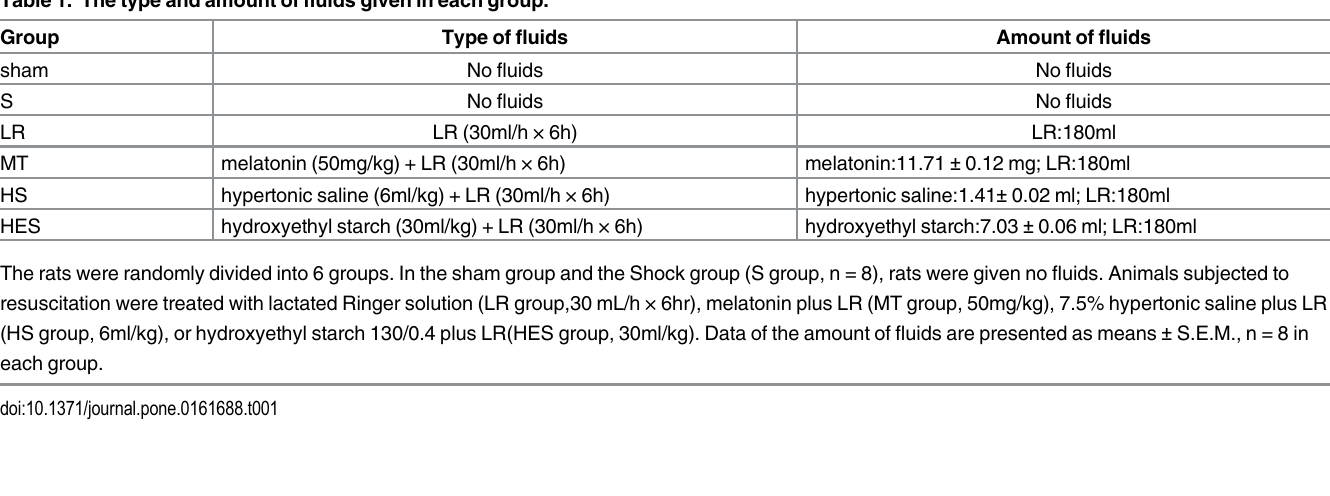
Table 1. The type and amount of fluids given in each group. Group